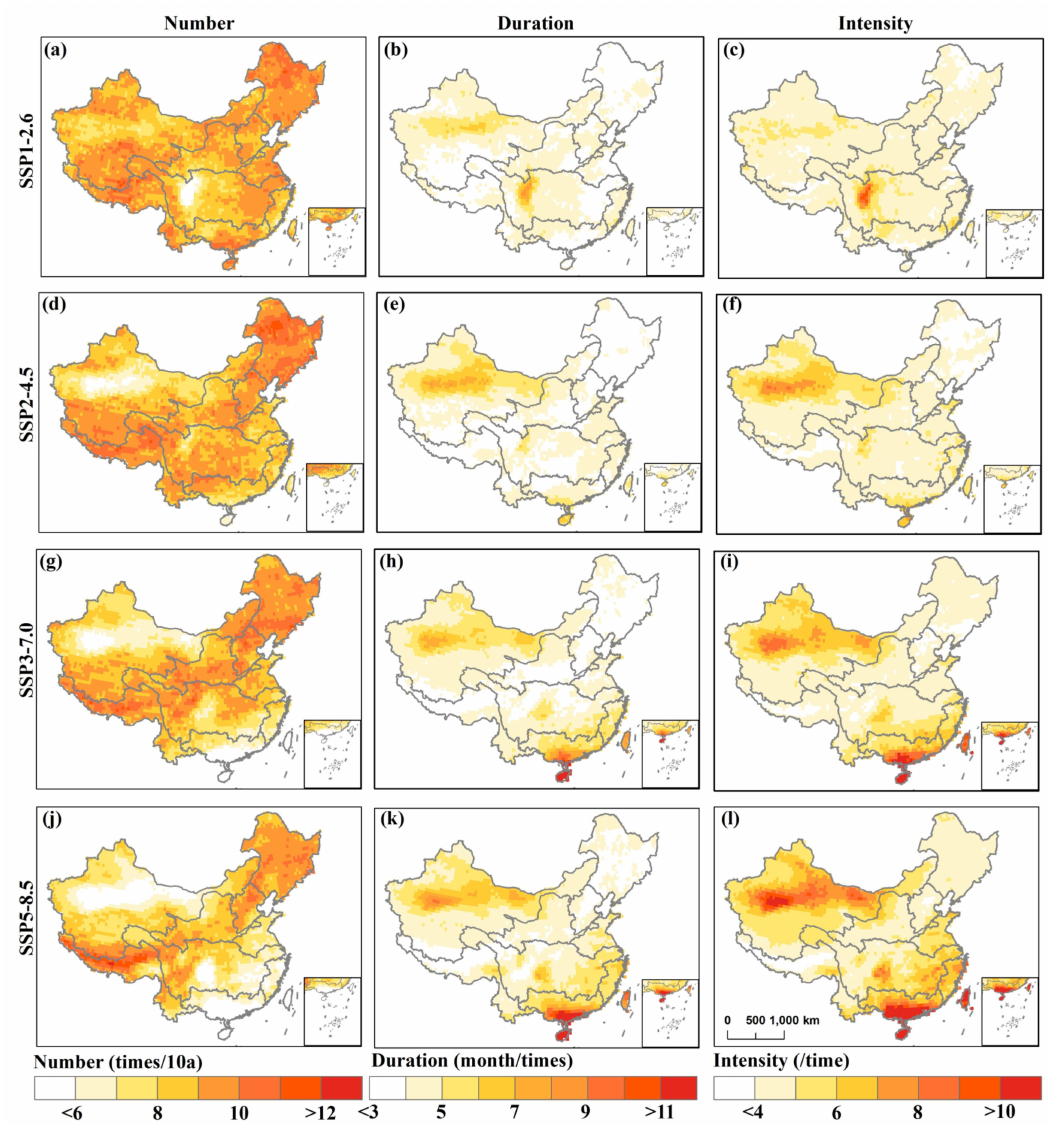
Figure 8. Comparison of the spatial pattern of DF ( a , d , g , j ), ( b , e , h , k ) DD, and ( c , f , i , l ) DI across China under the ( a – c ) SSP1-2.6, ( d – f ) SSP2-4.5, ( g – i ) SSP3-7.0, and ( j – l ) SSP5-8.5 scenarios for the future period